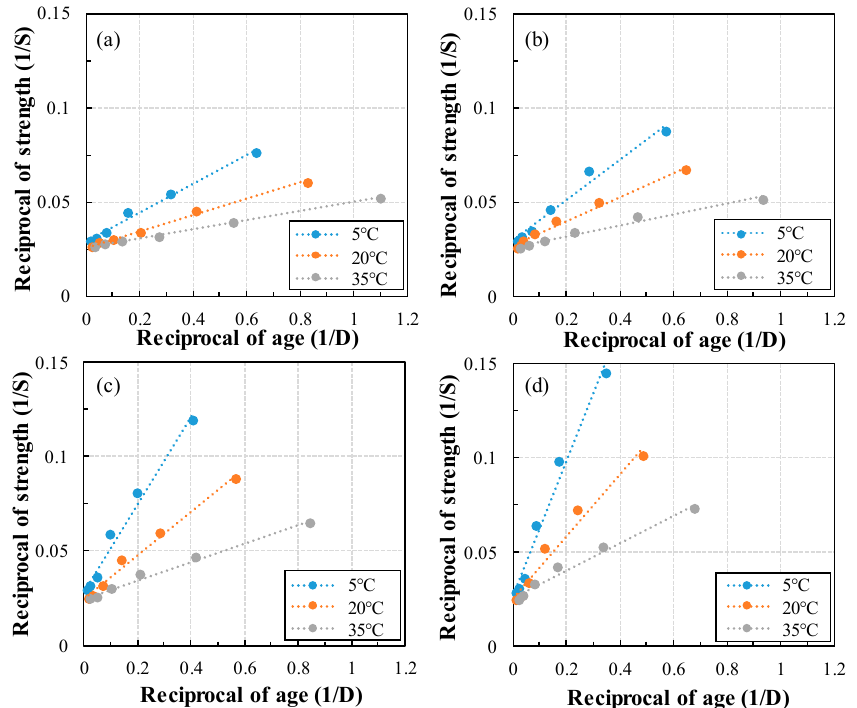
Figure 4. Regression analysis results for calculating k T ( a ) 0%, ( b ) 10%, ( c ) 30%, ( d ) 50% .